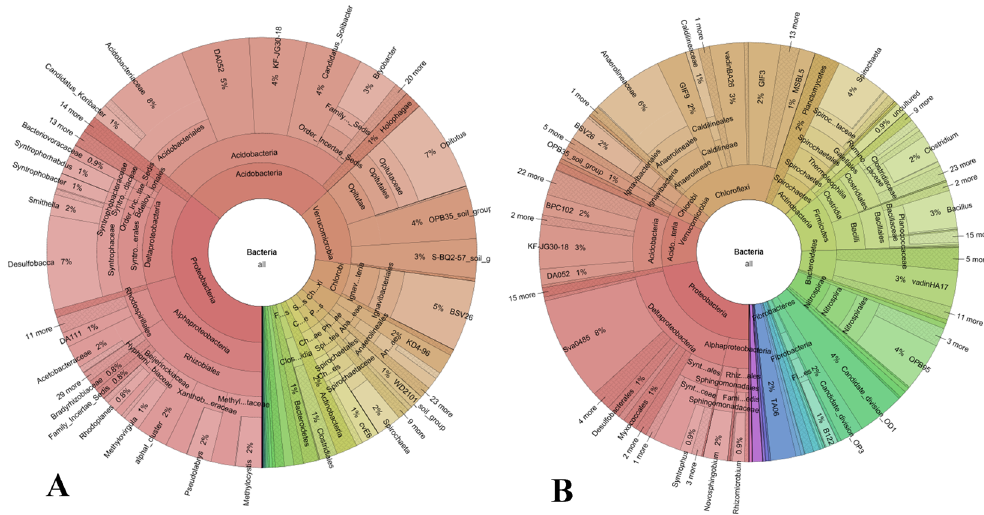
Figure 2. Krona pie chart plots of the bacterial communities proportional abundances (%) in the shallow (41 cm of depth) ( A ) and in the deep (279 cm of depth) ( B ) peat samples.